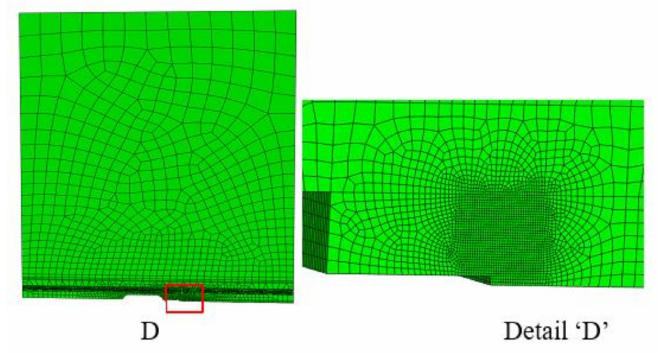
Figure 5. Finite element model of the WP specimen.